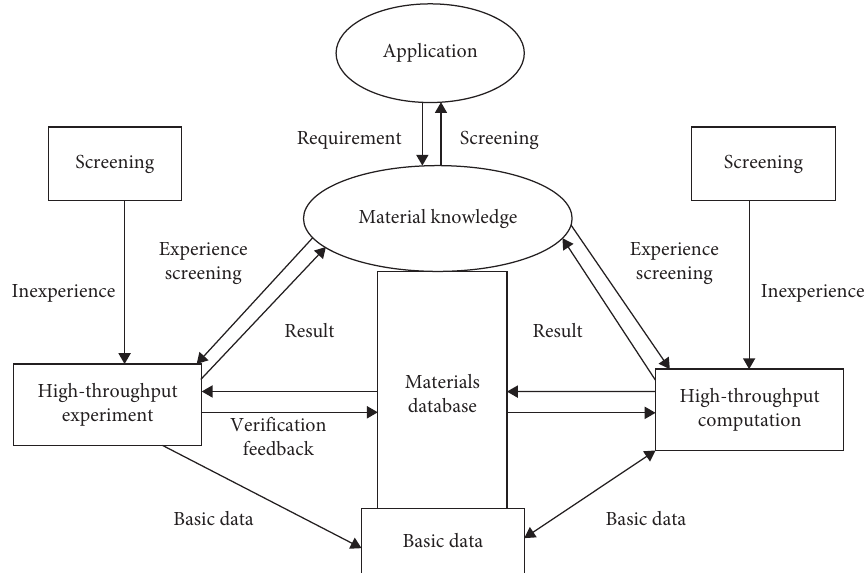
Figure 2: Collaborative work flow chart among three elements of materials genome technology